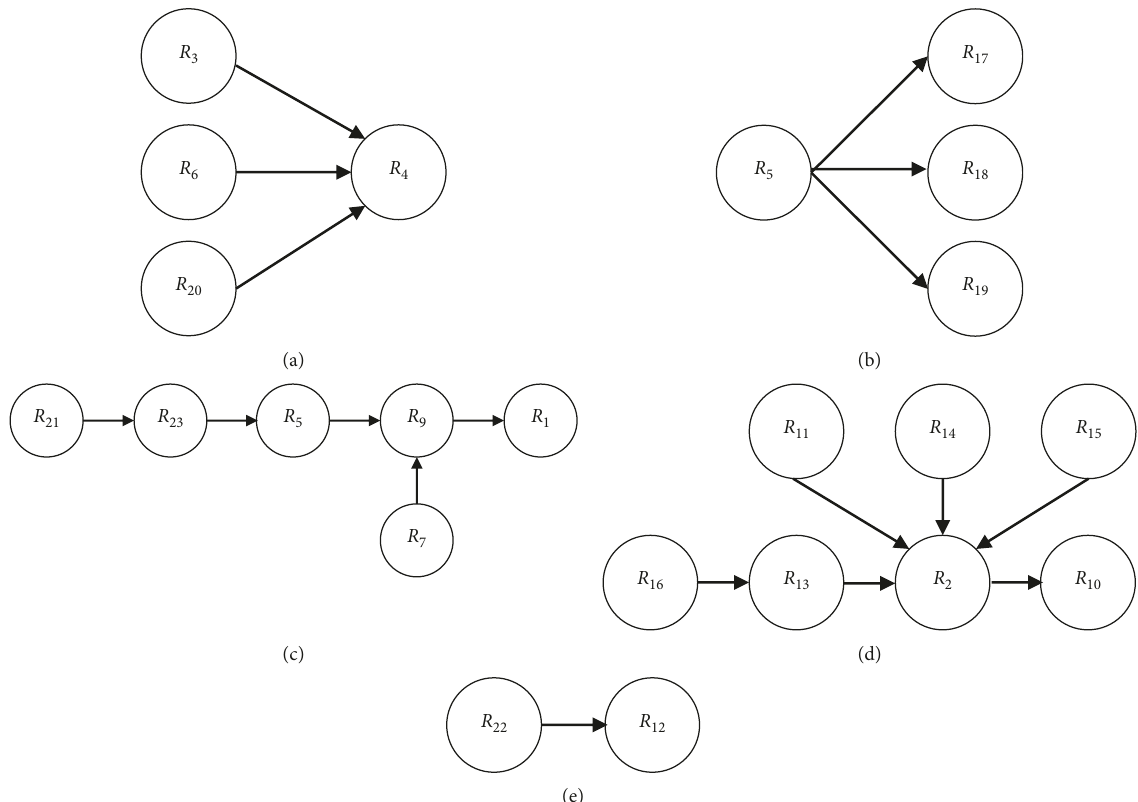
Figure 3: Diagram of Bayesian network risk factors.